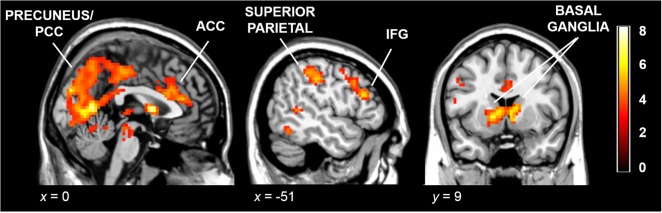
Whole-brain results.Average activation maps for the Switch > Repeat contrast overlaid on a standard brain (p < .05, cluster corrected with an auxiliary uncorrected threshold of p < .001). The right side of the image is the right side of the brain. The color bar depicts t values. PCC = posterior cingulate cortex; ACC = anterior cingulate cortex; IFG = inferior frontal gyrus.